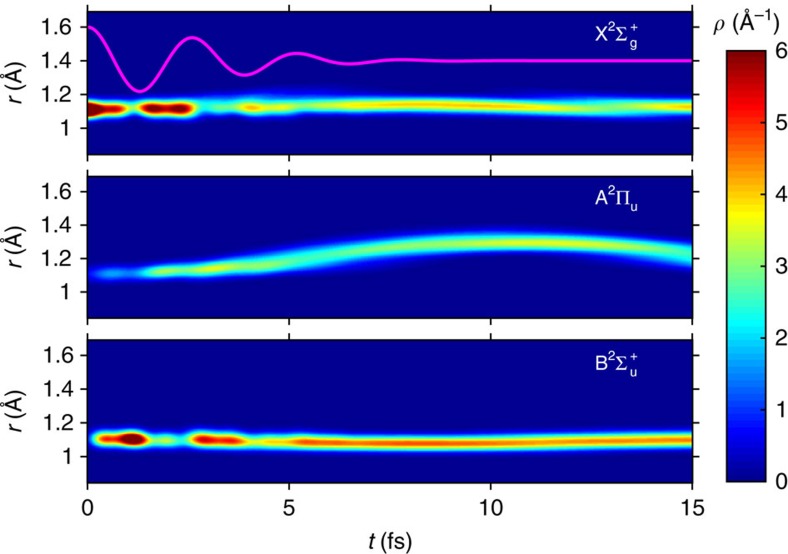
Time-dependent nuclear density .Nuclear densities in the X2Σg+ state (top), the A2Πu state (middle) and the B2Σu+ state (bottom). The laser parameters used are the same as in Fig. 2a. In the top panel (showing the X2Σg+ state), the laser field (on an arbitrary scale) is indicated as a solid line.